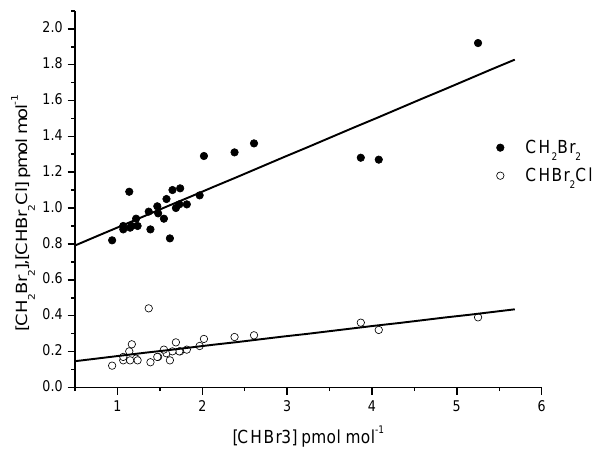
Figure 6. Plot for correlations of CH 2 Br 2 and CHBr 2 Cl versus Figure 6: Plot for correlations of CH 2 Br 2 and CHBr 2 Cl versus CHBr 3 concentrations. CHBr 3 concentrations.